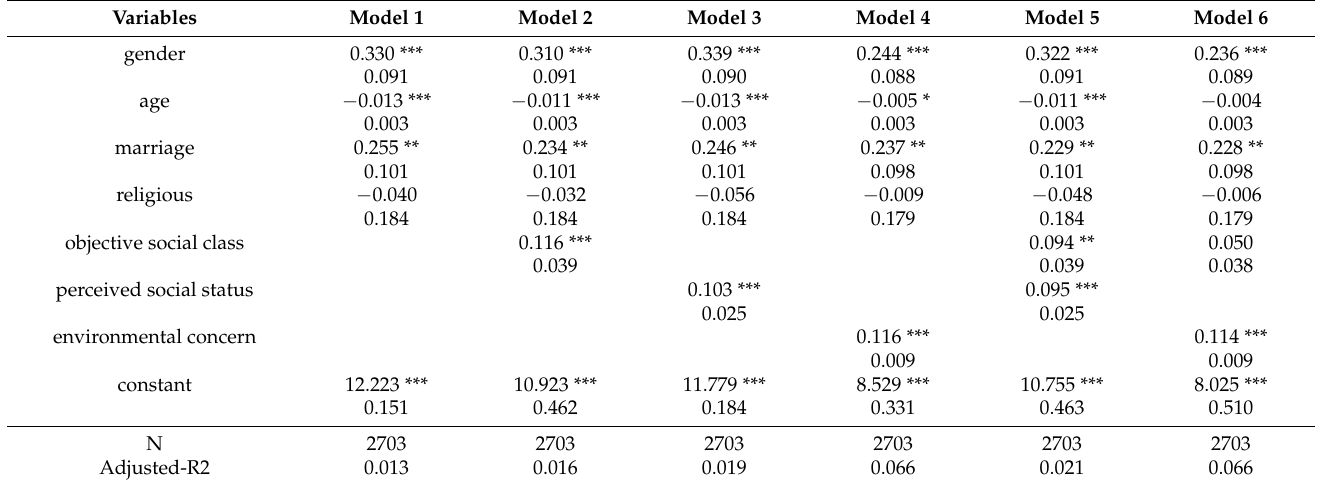
Table 3. Ordinary Least Square regression models private-sphere green